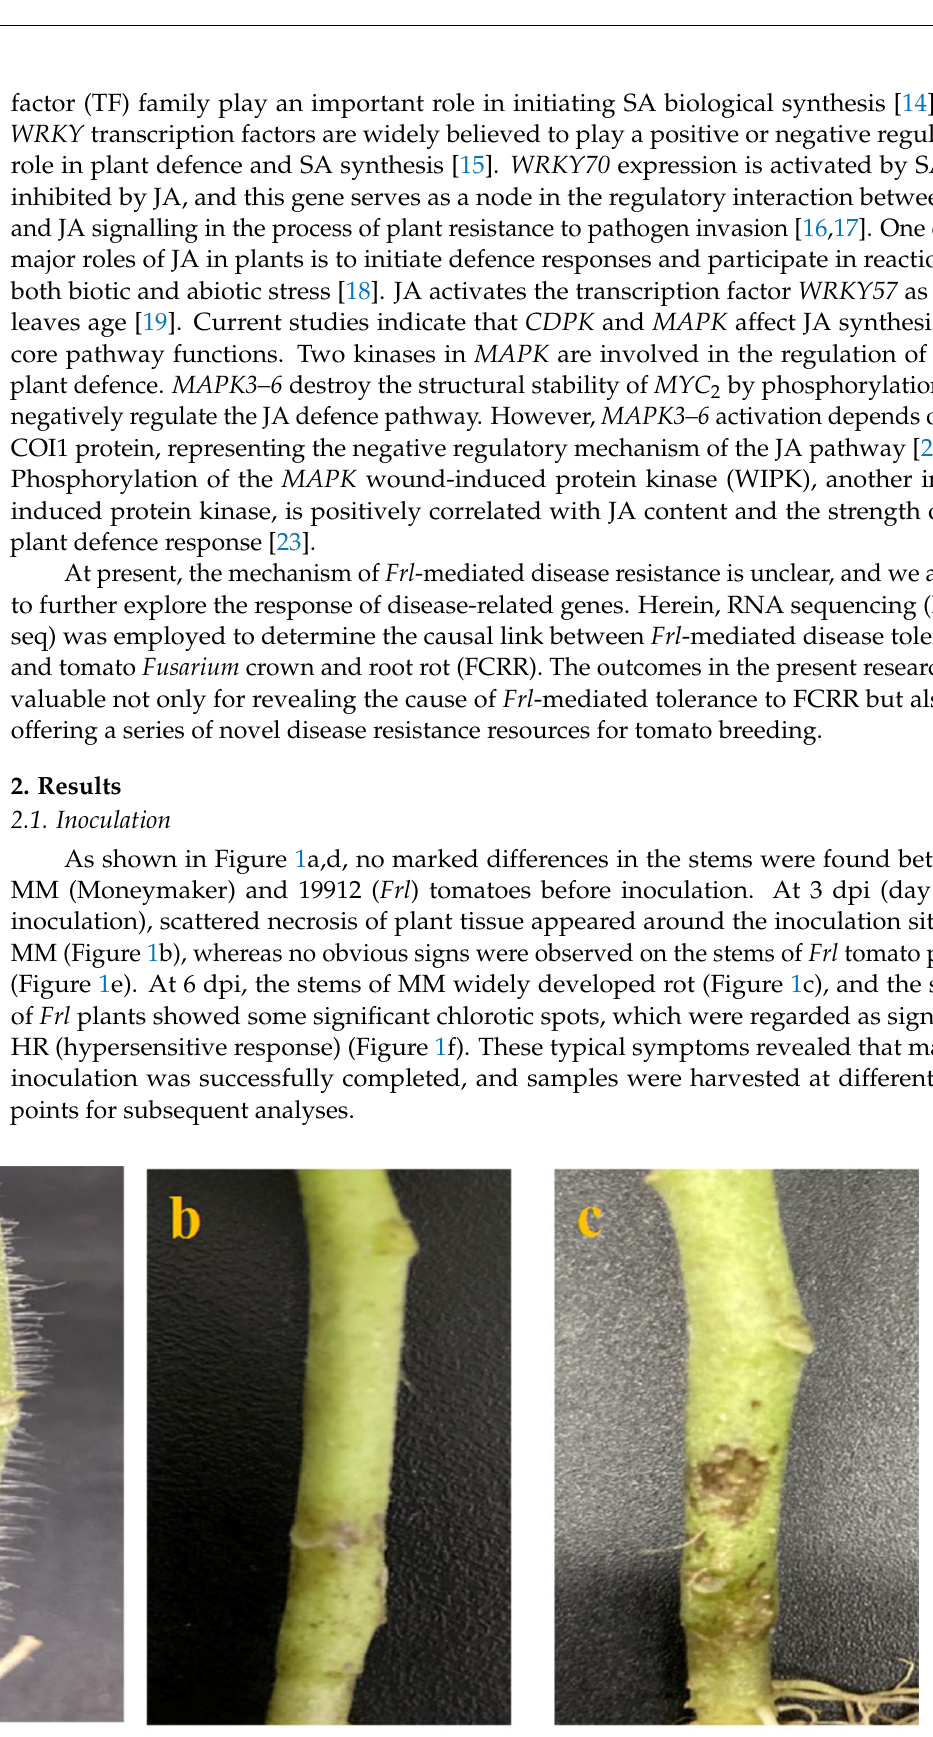
Figure 1. Results of inoculation. ( a – c ) ‘Moneymaker’ inoculated with FORL ( Fusarium oxysporum f. sp. radicis-lycopersici ) at 0, 3, and 6 dpi; ( d – f ) ‘19912’ inoculated with FORL at 0, 3, and 6 dpi. 2.2. Microscopic Analysis of FORL Growth in Two Tomato Cultivars FORL infections in the Frl and MM stems were studied using optical microscopy, scanning electron microscopy, and transmission electron microscopy. As shown in Figure 2a,f, no obvious differences were noted between Frl and MM stems at 0 dpi. The spores started to germinate at 1–2 dpi (Figure 2b), and hyphae invaded the stomata in Frl and MM tomato stems (Figure 2c). At 3 dpi, mycelia and necrotic spots appeared on MM to- mato stems (Figure 2d), and HR was observed on the stems of the Frl tomato plant (Figure 2g). At 6 dpi, with the development of the disease, mycelial invasion continued, the dis- eased area in MM tomato stems continuously expanded, and the chloroplast membrane was destroyed, which causes serious disease in the plant (Figure 2e). However, in resistant cultivar 19912, mycelium growth was limited, and the chloroplast structure was intact (Figure 2h). Plants carrying the Frl resistance gene (19912) exhibited evident HR posterior to the FORL exposure site, but susceptible plants (MM) showed continuous mycelium growth.